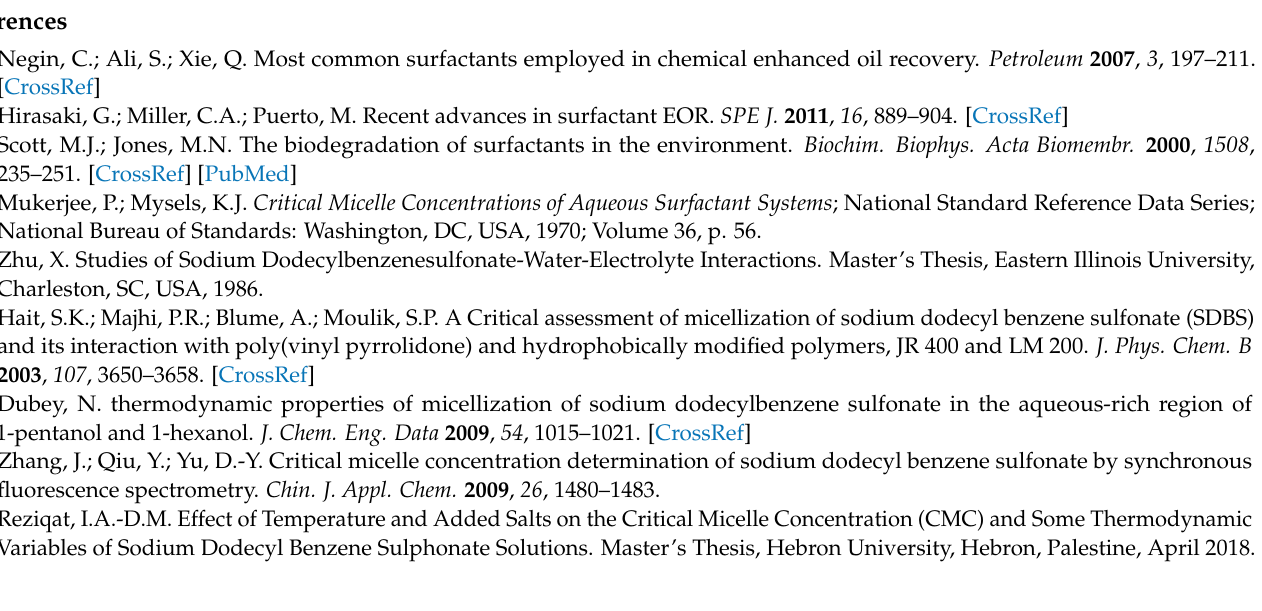
index as a function of NaLAS concentration, in the presence of CaCl 2 ; Figure S4: Powder X-ray diffractograms of NaLAS and precipitates formed by adding CaCl 2 to solutions of the surfactant, at two different Ca 2+ :NaLAS weight ratios; Figure S5: Powder X-ray diffractograms of CaLAS 2 precipitates, calcined at 900 ◦ C or 1000 ◦